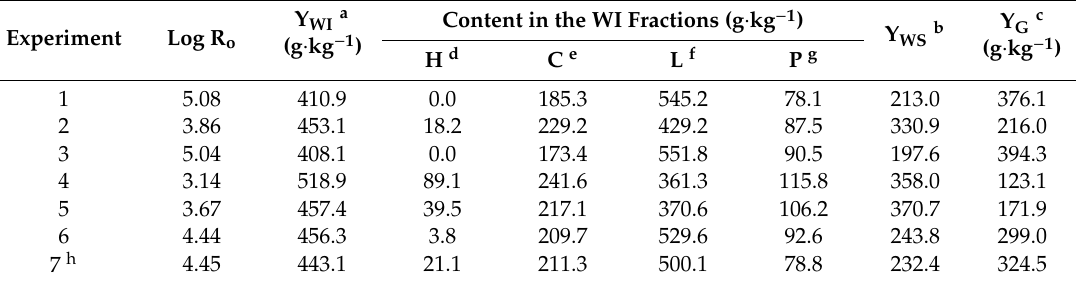
Table 2. The yields of WI and WS fractions obtained in the experimental series using OED, and the contents of unreacted hemicellulose, cellulose, sulfuric acid-insoluble products and protein in solid post-reaction residues presented as a function of the severity